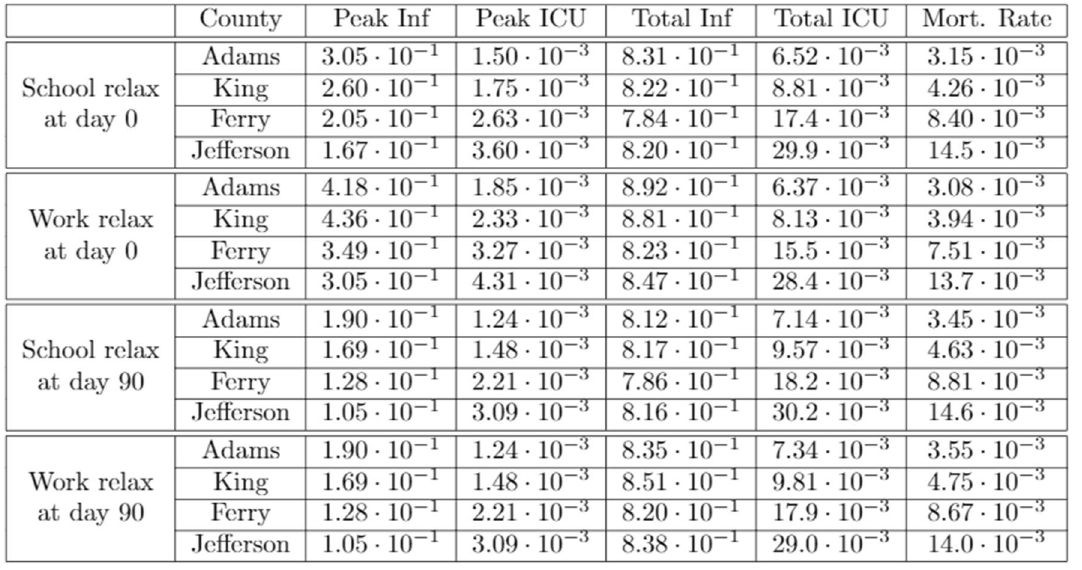
Figure 12. Age-specific policy